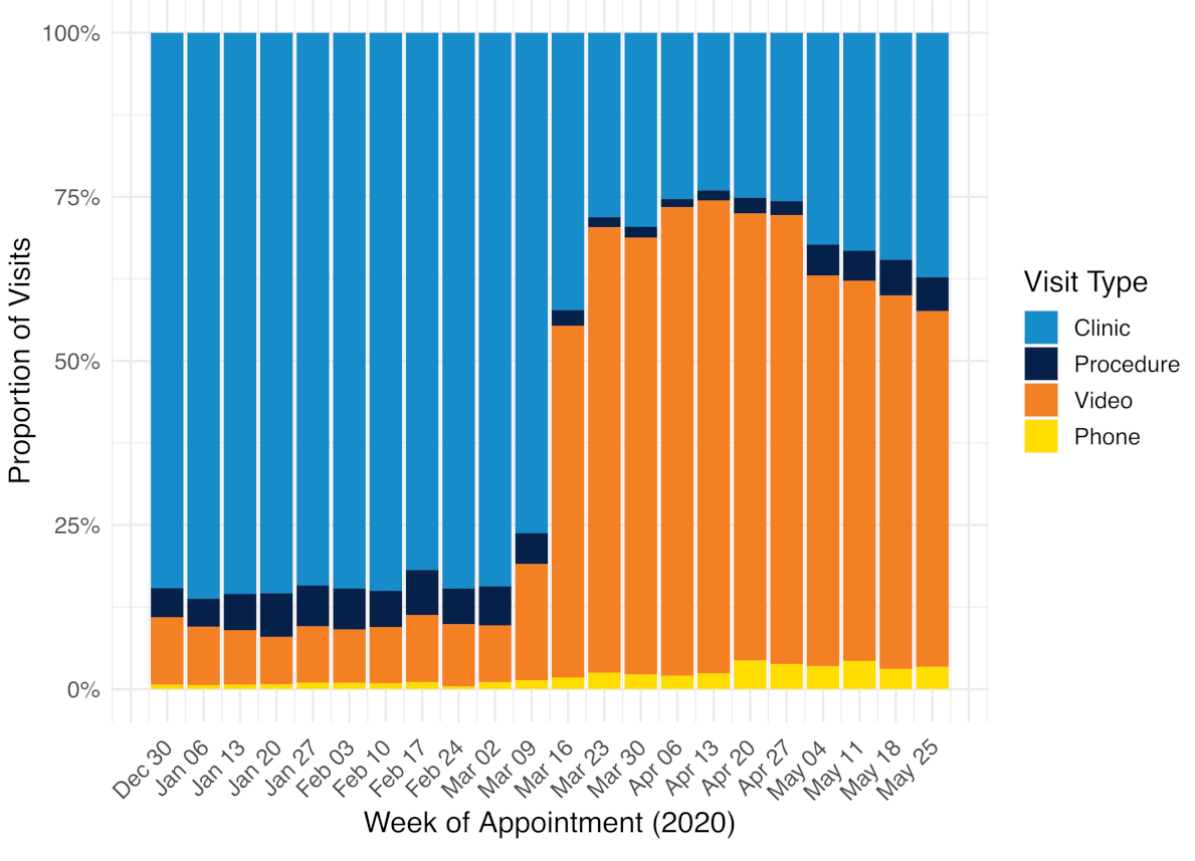
Figure 3. Relative weekly trends in clinic encounters, stratified by visit type (in-person visits, procedural visits, video visits, and phone visits) from January 1 to May 31, 2020, with March 16, 2020, denoting the institution-wide transition to video visits in response to coronavirus disease